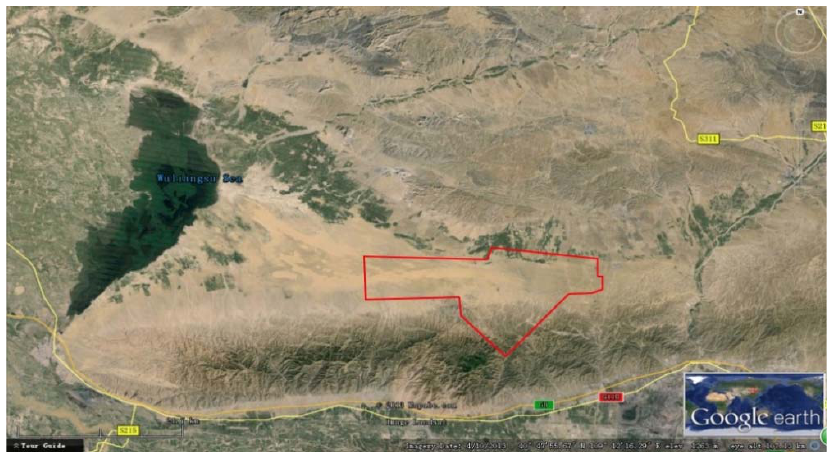
Figure 2. The RadCalNet Baotou